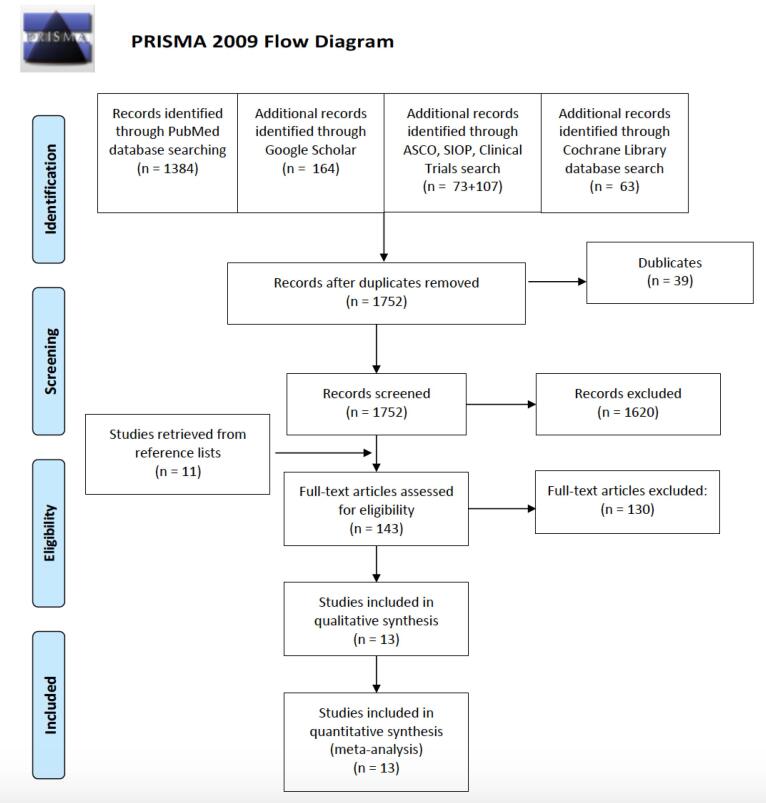
PRISMA (Preferred Reporting Items for Systematic Reviews and Meta-Analysis) guidelines flowchart demonstrating the search strategy.